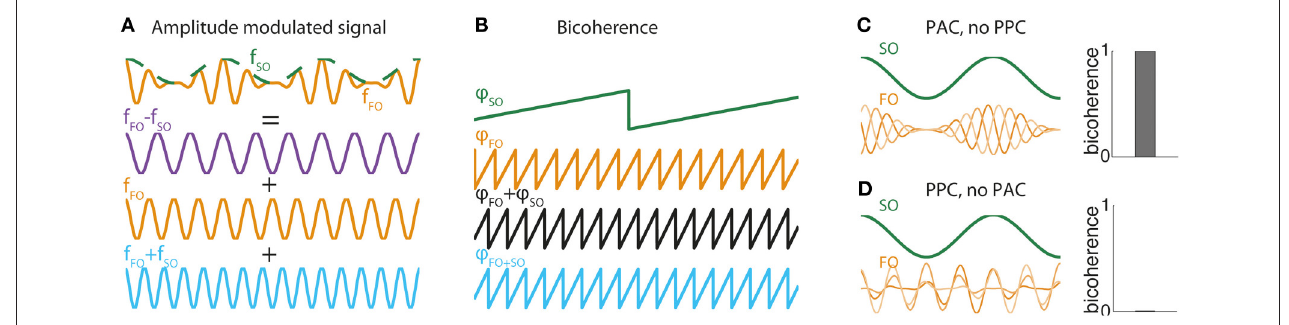
FIGURE 1 | (A) FO-SO beats. Illustration of how a sinusoid of frequency f FO (orange curve) whose amplitude is modulated by an oscillation of frequency f SO (green curve) can be decomposed mathematically as the sum of three pure sinusoids, one of difference frequency f FO − f SO (purple curve), one of the faster frequency f FO (orange curve), and the third of sum frequency f FO + f SO (orange curve). This mathematical equivalence between the generative form of an amplitude modulated signal and its Fourier decomposition is the basis for the bicoherence measure. (B) Bicoherence in the amplitude-modulated system of (A) . Plot show phases at frequency ϕ SO (green curve) and frequency ϕ FO (orange curve) and the sum of phases ϕ SO + ϕ FO (black curve). The sum of phases is exactly equal to the phase of oscillation at frequency ϕ SO + FO (blue curve). This association is detected by the bicoherence measure. (C) Bicoherence in a system with PAC but no PPC. Two-hundred trials were simulated with a constant SO sinusoid and a FO sinusoid whose amplitude was modulated at SO frequency. The amplitude modulation was exactly locked to SO in all trials (PAC), whereas the phase of the FO sinusoid was drawn randomly (no PPC). Bicoherence (right panel) reached the maximal value of 1. (D) Absence of bicoherence in a system with PPC but no PAC. The same model as (C) was simulated, but instead the amplitude modulation had a randomly distributed phase (no PAC) while the phase of the FO sinusoid was locked in all trials to the SO oscillation (PPC). Bicoherence vanished completely (right